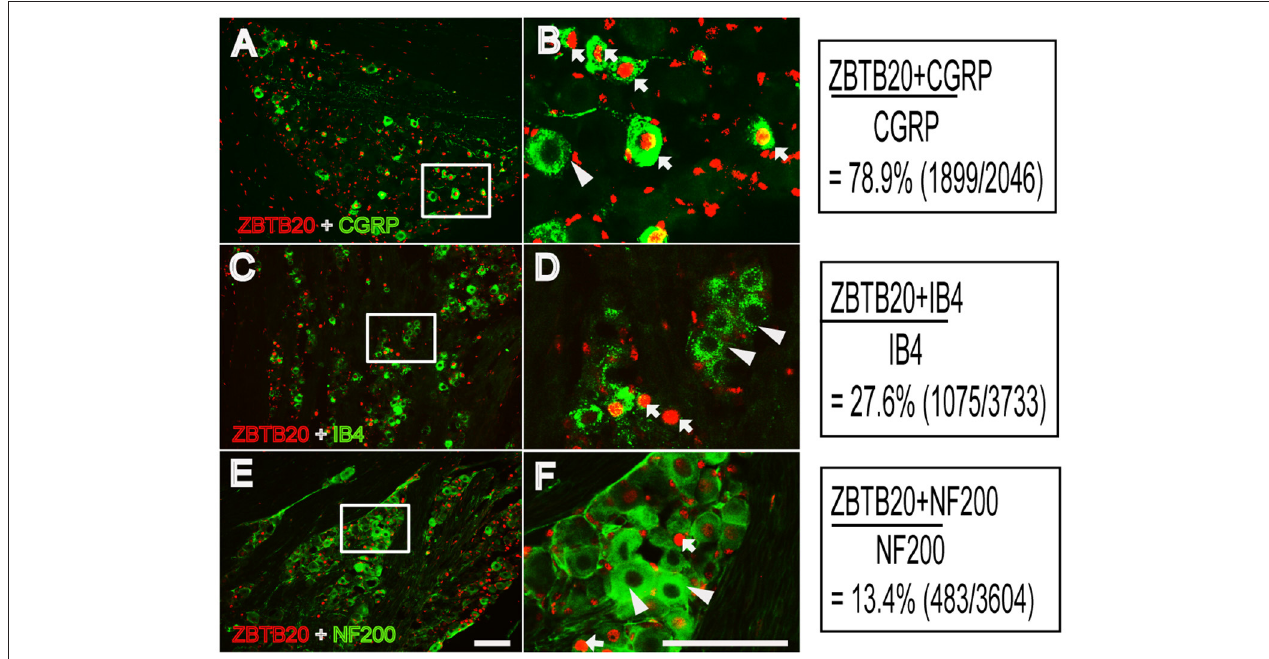
FIGURE 4 | Colocalization of ZBTB20 with CGRP, IB4, and NF200 in the trigeminal ganglia. (A,B) Colocalization of ZBTB20 with CGPR. (C,D) Colocalization of ZBTB20 with IB4. (E,F) Colocalization of ZBTB20 with NF200. Figures B,D,F are high magnifications of the boxes in Figures A,C,E . The arrowhead indicates the colocalization of ZBTB20 with CGRP, IB4, and NF200 in Figures B,D,F . The arrow indicates the expression of CGRP, IB4, and NF200 without colocalization with ZBTB20 in Figures B,D,F . N = 3; bar = 50 µ